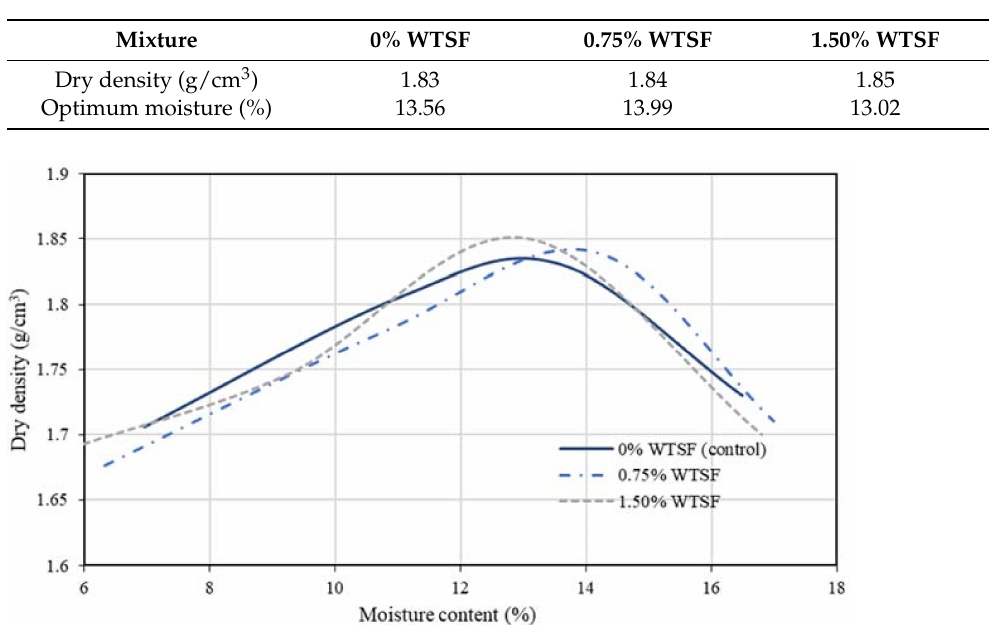
Figure 7. Proctor test’s compaction